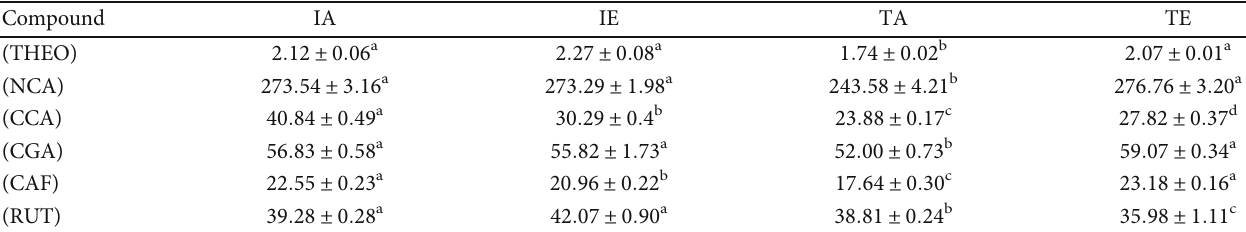
Table 1: Content of the major compounds of I. paraguariensis extracts by LC-UV (mg · g -1 ). Di ff erent letters indicate signi fi cant di ff erence content in the same compound among di ff erent extraction procedures (ANOVA, followed by Tukey test; p < 0 : 05 ).